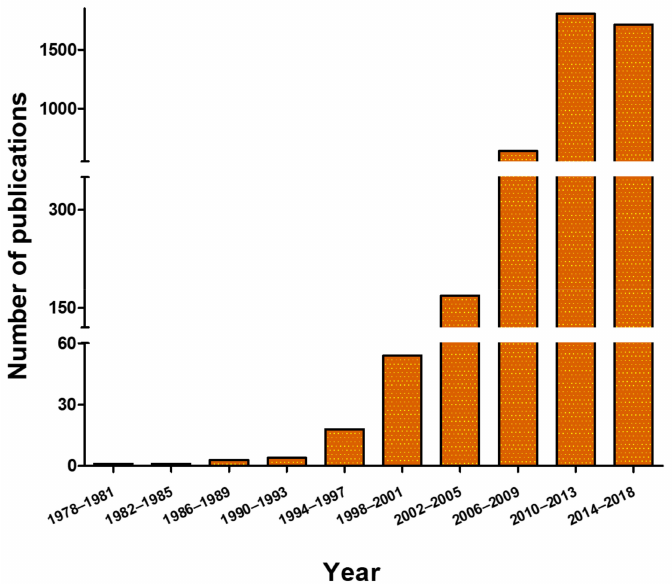
Figure 4. Number of scientific works based on ANVs published since